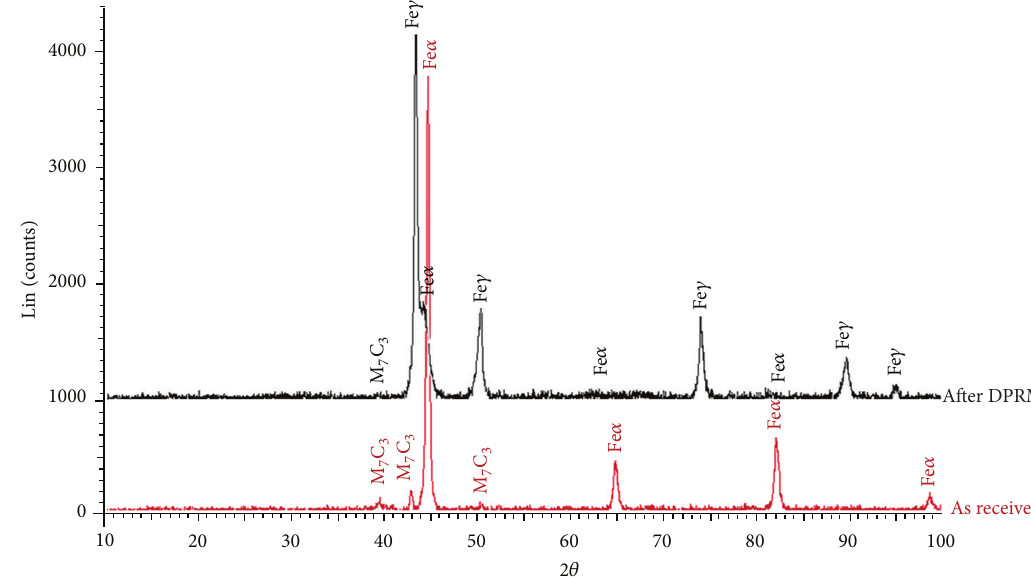
Figure 9: X-ray diffraction pattern for as-received and after direct partial remelting